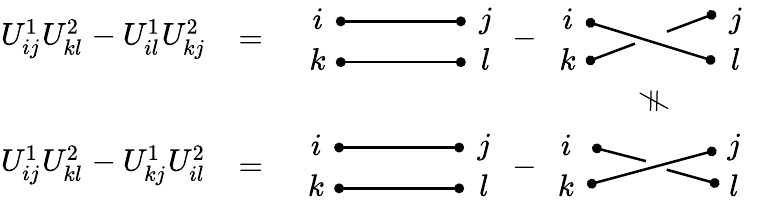
Figure 8 . The figure shows a state of two open strings. Antisymmetrization of the right and left indices can be expressed by fixing the Chan-Paton factors while changing the pattern of connection between them. In the figure we have put string number 1 on top of string number 2. When the open strings have bosonic statistics as imposed by the S n quotient in (5.10), the antisymmetrization of the left or the right endpoints give the same state, since the two operations are relating by commuting string number 1 and 2. However, the A-model open string has anyonic statistics, so the two orderings are not equal. This corresponds a nontrivial braiding structure in the diagrams